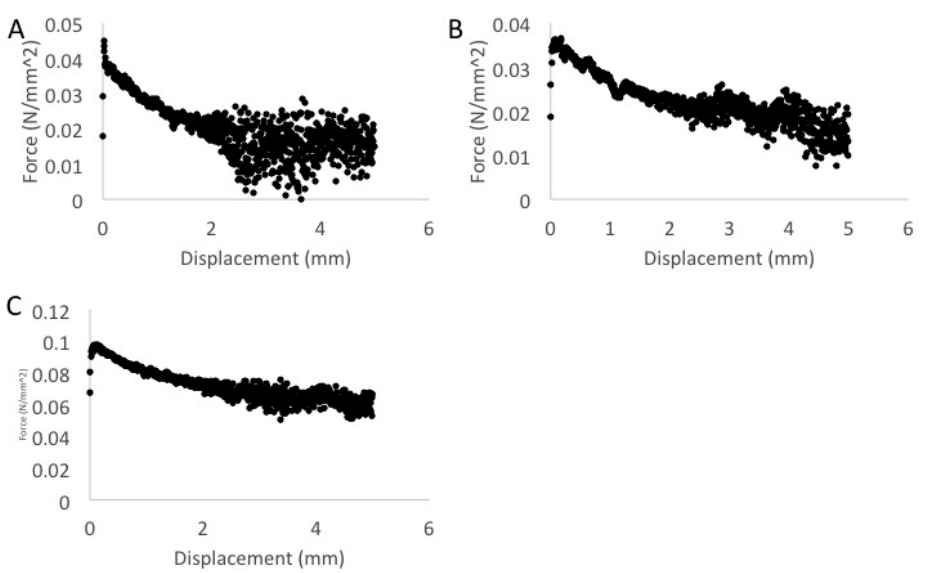
Figure 7. Compression tests of formulation 1 with drugs ( A ) and without drugs ( B ) as well as formulation 4 with drugs ( C ). Notice that the compression behavior of the composition changes quite a bit in the absence of vancomycin and is able to withstand more stress prior to plastic deformation.